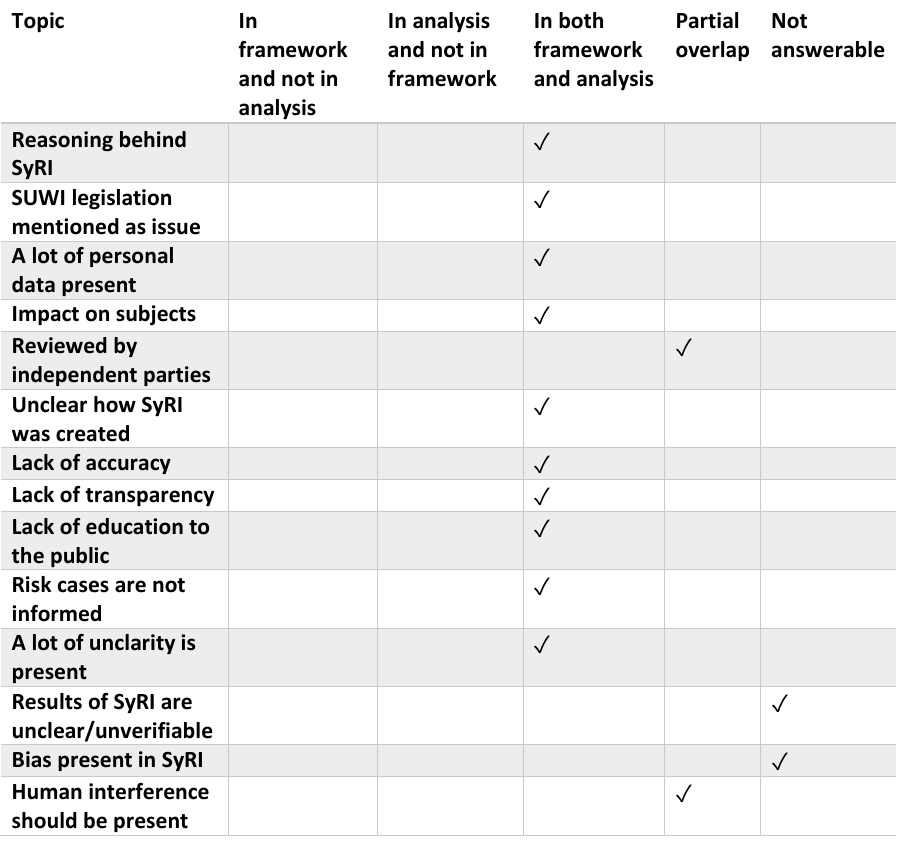
Figure 3. Results of a comparison of specific ethical concerns between the framework, the court case and the media on whether questions in the framework could be answered with a yes, maybe, no, or were not answerable. ( a ) Exact numbers. ( b ) Percentages.